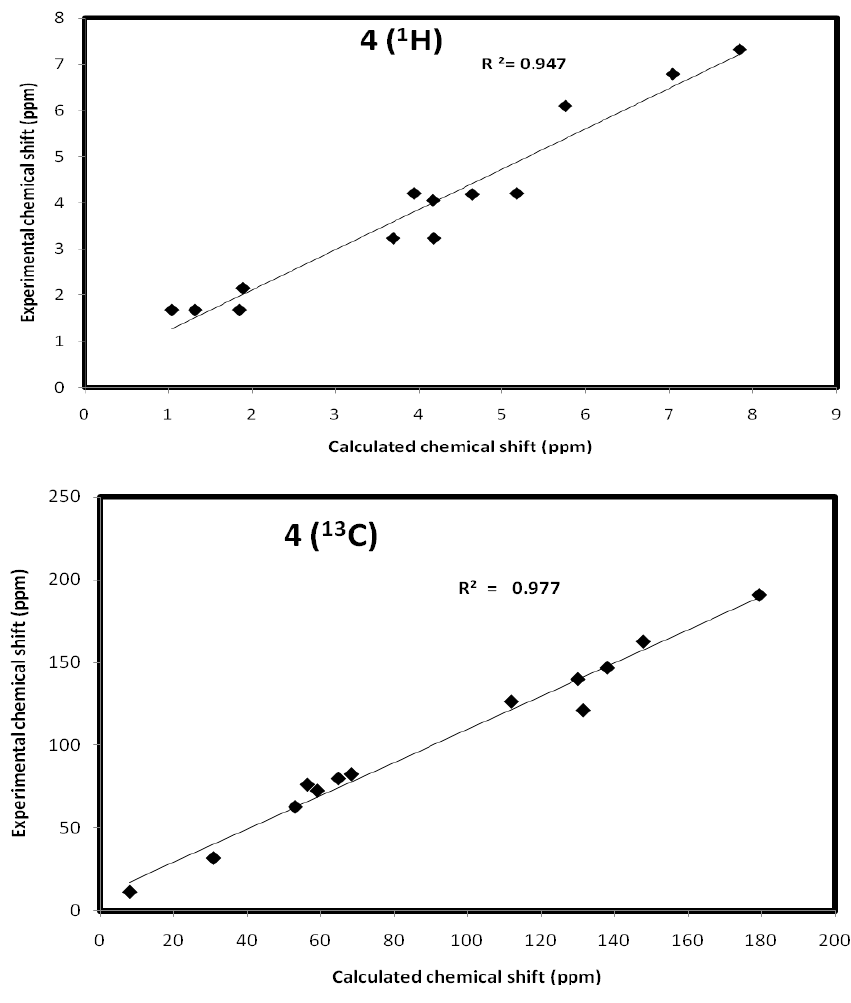
Figure 5. The correlation graphs between the calculated and experimental chemical shifts compound 4 . Table 6. Calculated and experimental NMR chemical shifts of compound 5